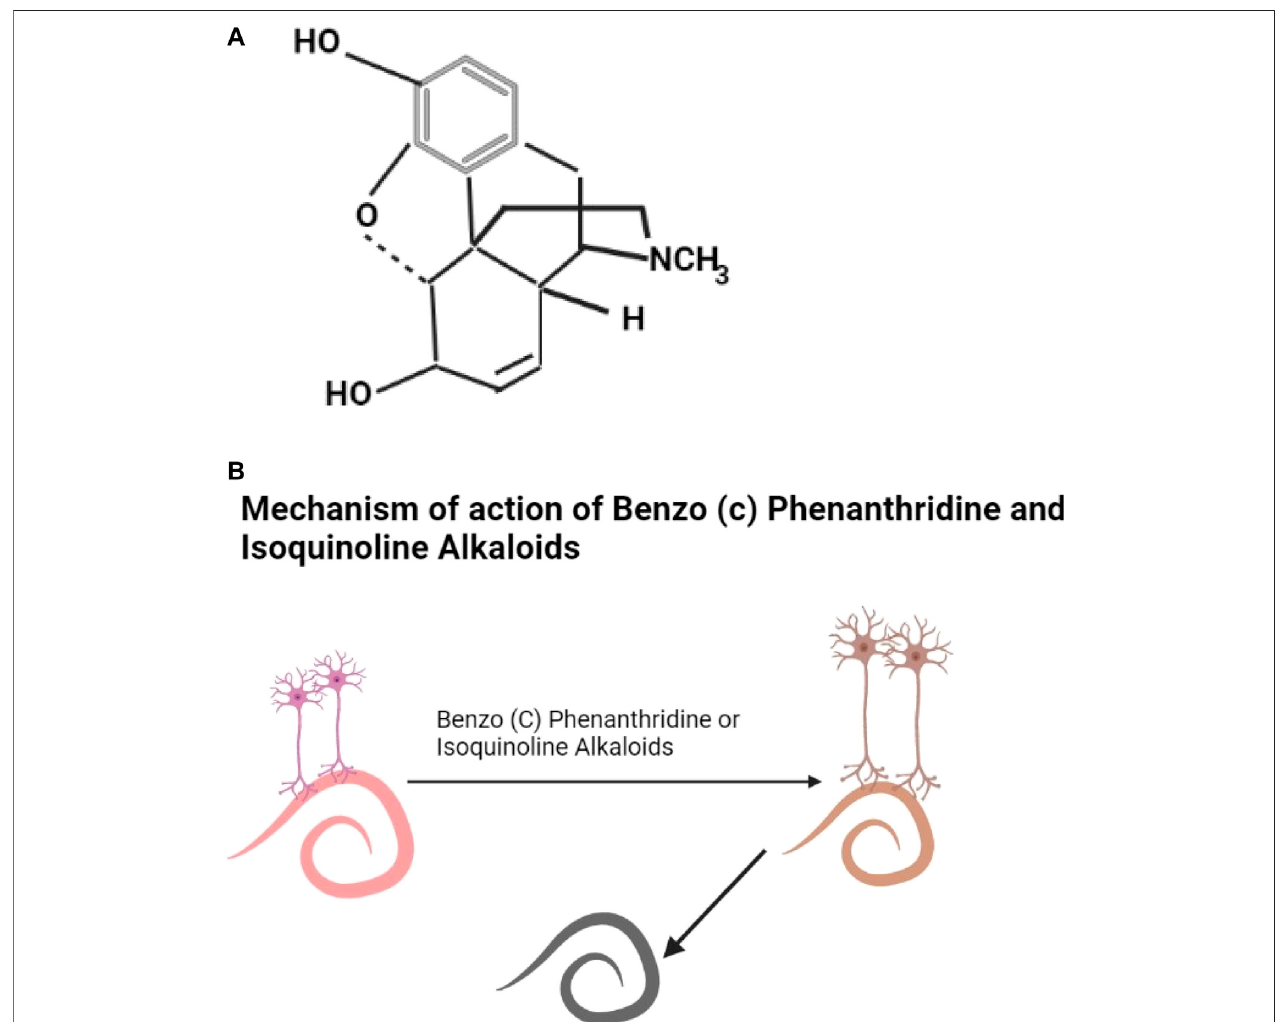
FIGURE 2 | (A) The structure of morphine (Verpoorte, 2005). (B) Benzo (c) phenanthridine or isoquinoline alkaloids damage helminth neurons leading to the death of the